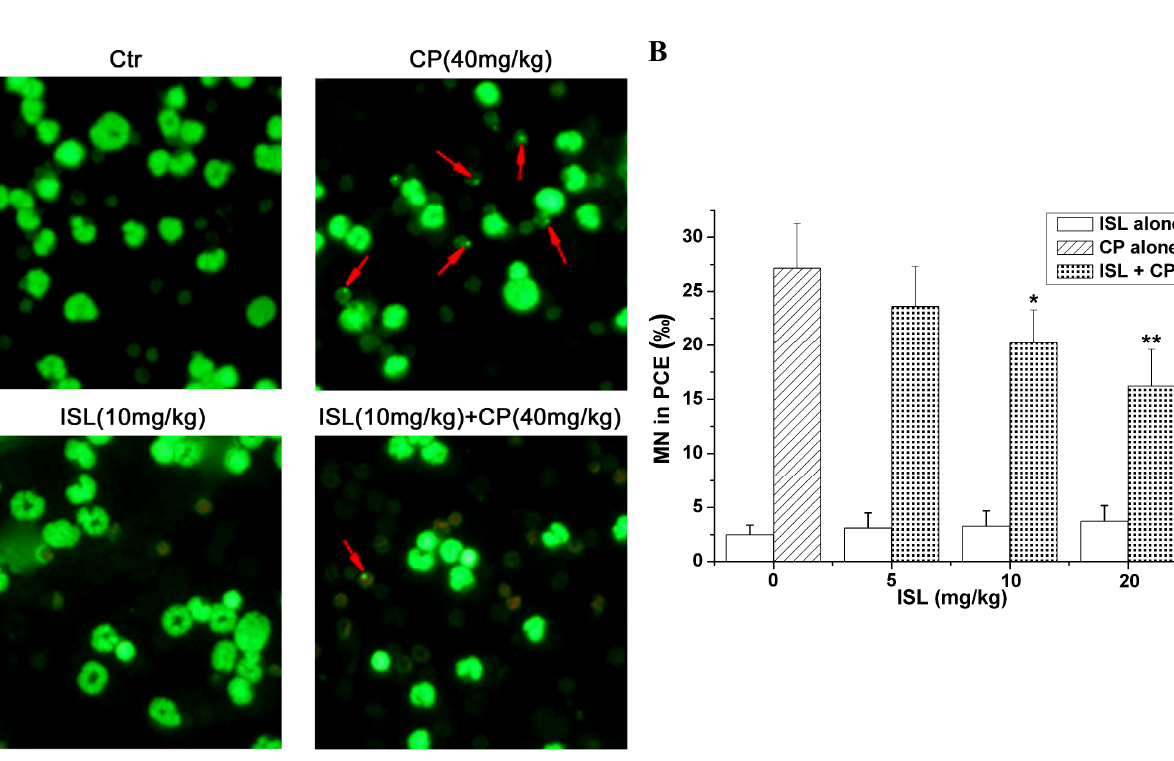
* p < 0.05, ** p < 0.01 versus CP-treated